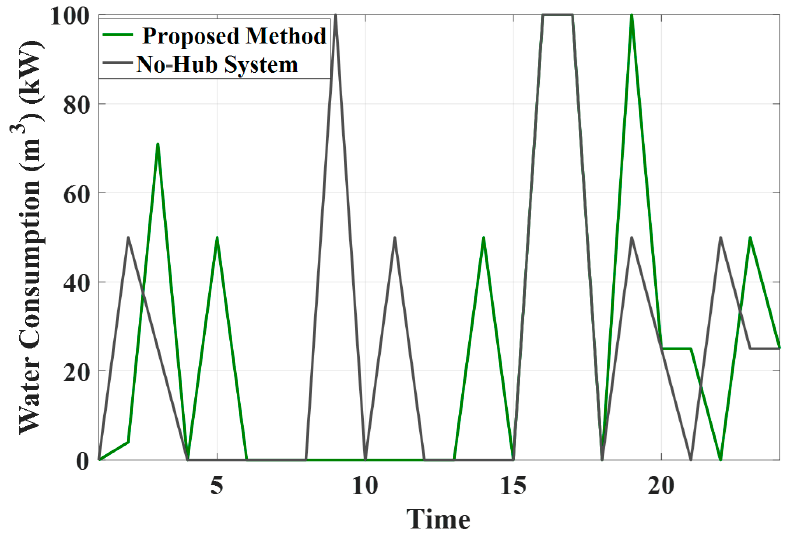
Figure 9. The water consumption for two methods: (1) proposal (2) no hub.